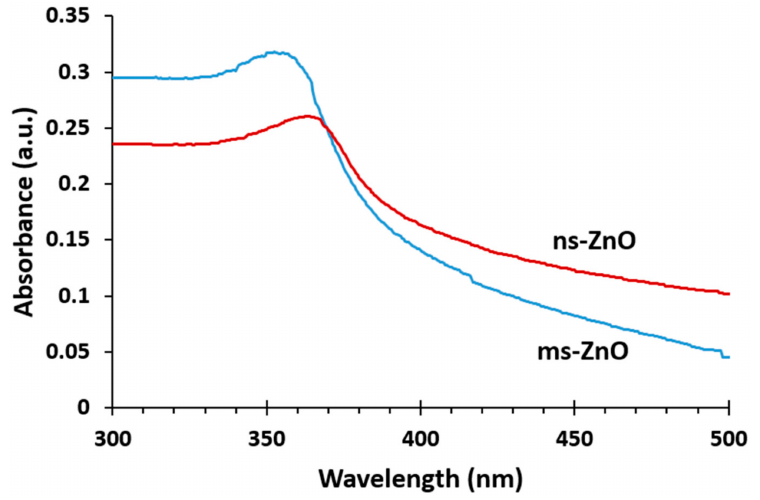
Figure 1. UV-vis absorption spectra of as-prepared ZnO nanosphere (ns-ZnO) and ZnO nanorod (ms-ZnO) colloids in water.